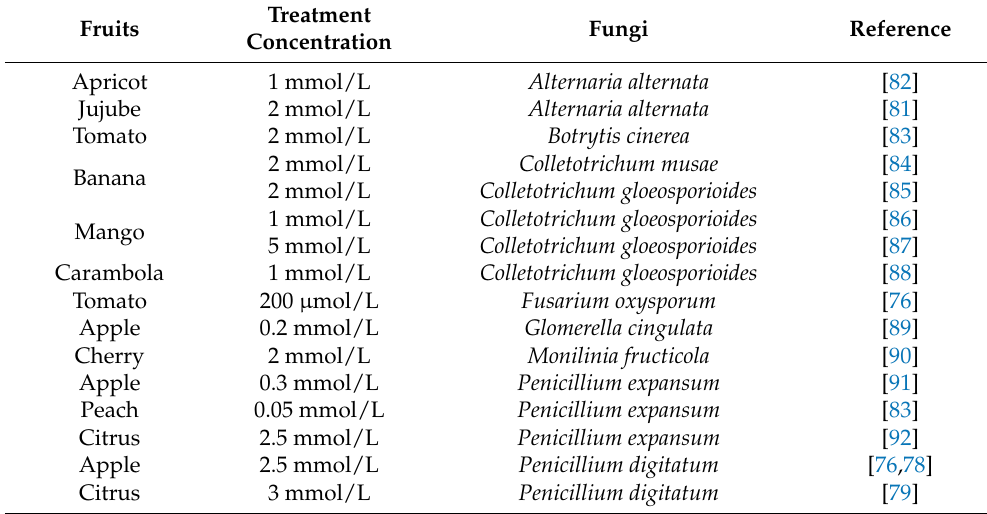
Table 2. Studies on the induced resistance effect of SA treatment to different type of fungus in postharvest